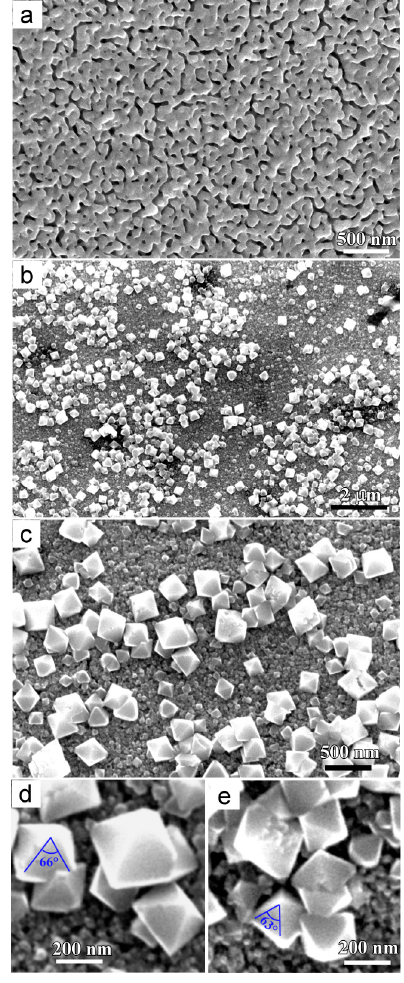
Figure 2. Microimages of nanoporous Cu before ( a ) and after an immersion treatment in water for 72 h ( b ), high magnified morphology ( c ) and octahedral Cu 2 O particles ( d , e ).